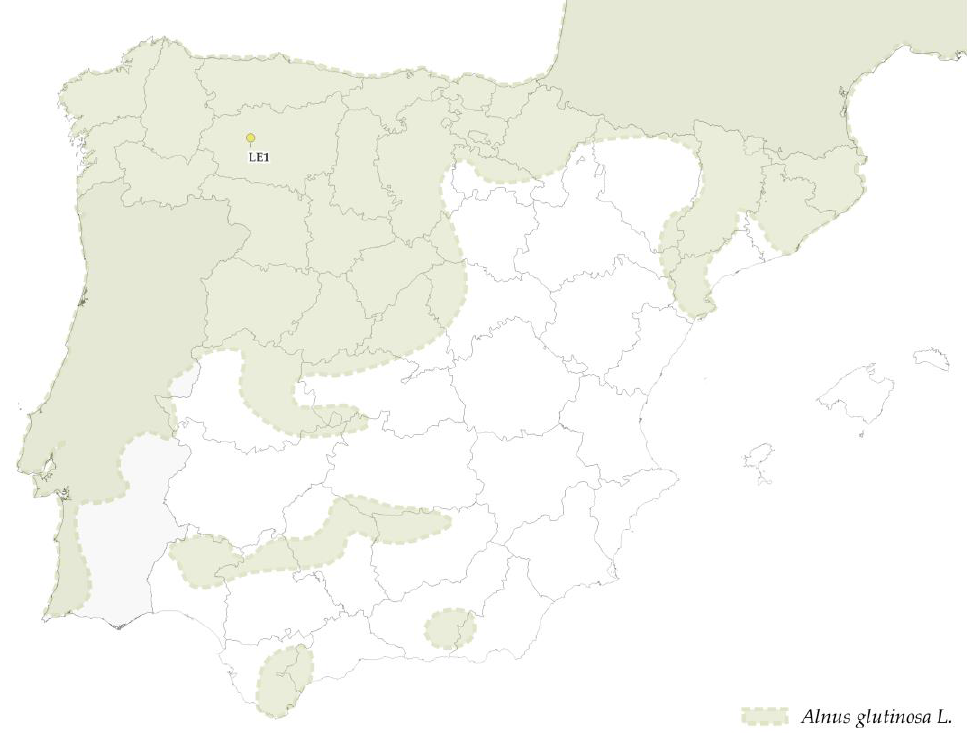
Figure 17. Distribution map of the species Alnus glutinosa L. and location of the cases identified as belonging to this species. Map drawn up by the authors using information obtained from the database Chorological Data for the Main European Woody Species